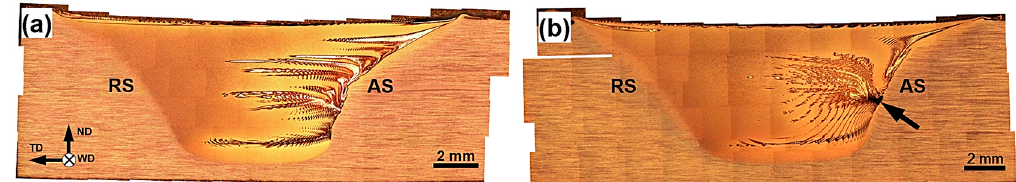
Figure 1. Low-magnification optical images showing a transverse cross section of samples processed using a feed rate of ( a ) 15 mm / min or ( b ) 30 mm / min. RS and AS denote the retreating side and the advancing side, respectively. The reference frame for both cases is shown in the bottom left corner of ( a ). In ( b ), the arrow indicates a tunnel-type defect.